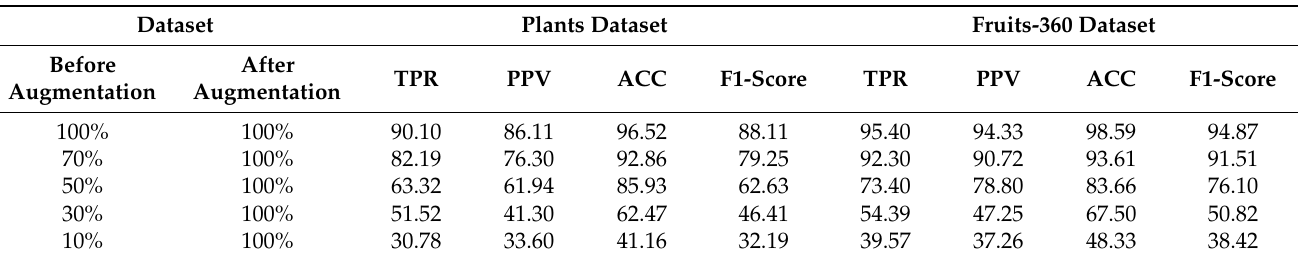
Table 21. Comparison of accuracies achieved by the proposed PI-CNN in the original and augmented datasets. The accuracies were achieved in the Plants and Fruits-360 dataset (unit: %).